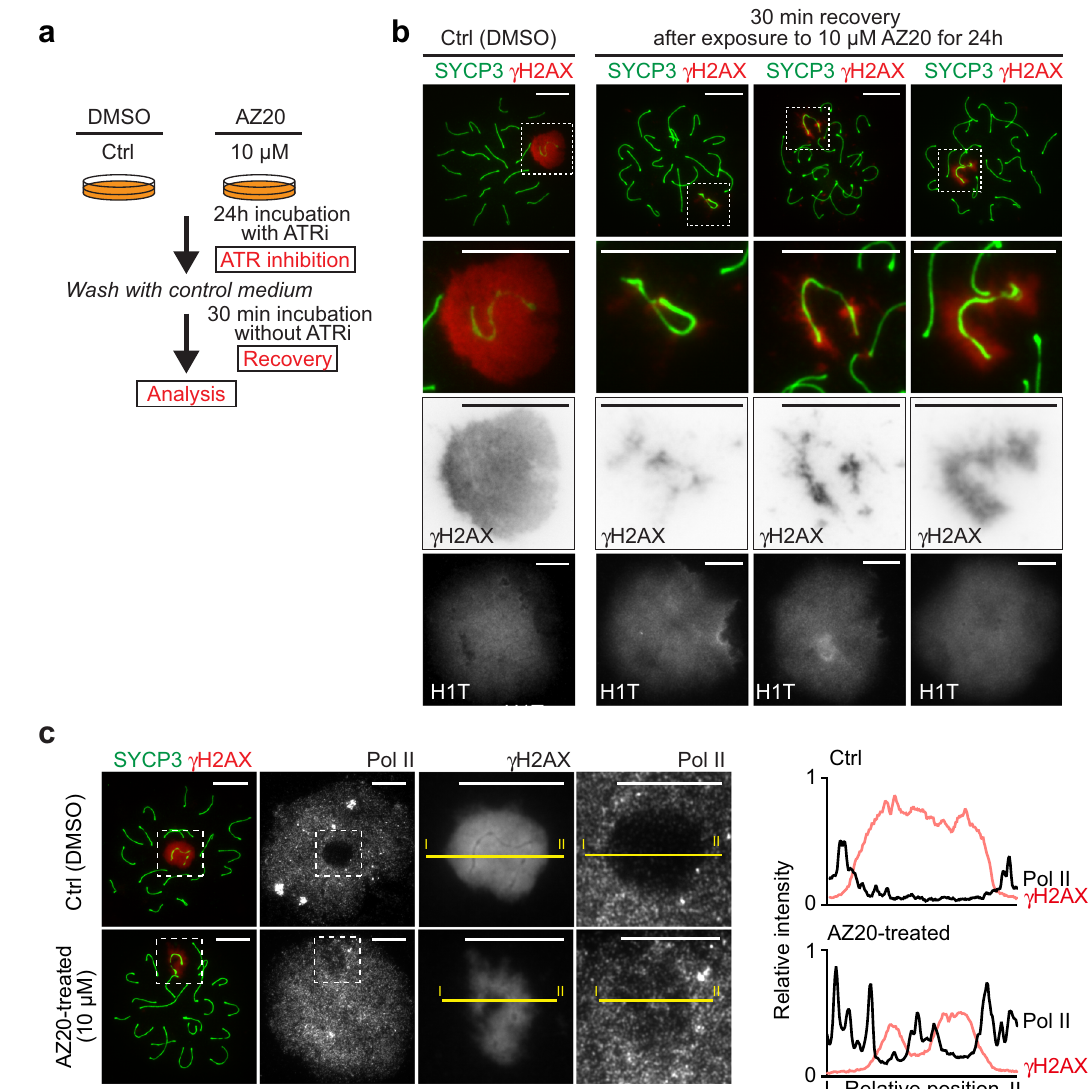
Fig. 5 | ATR-dependent reestablishment of MSCI from unsynapsed axes. a Schematic of the experimental design. Following 24h incubation with the ATRi AZ20, spermatocytes were additionally incubated for 30min without ATRi. b , c Chromosome spreads of mid-late pachytene spermatocytes harvested 30 min afterrelease from a 24h incubation with ATRiand immunostained with antibodies raised against SYCP3, γ H2AX, and H1T ( b ) and SYCP3, Pol II, and γ H2AX ( c ). Representativeimagesof3independentexperimentsareshown.XYchromosomes